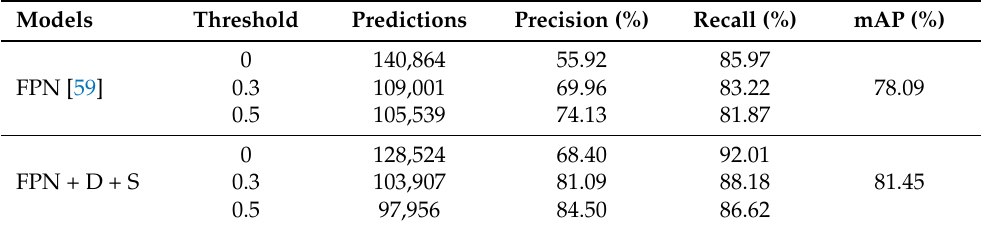
Table 2. Detection threshold